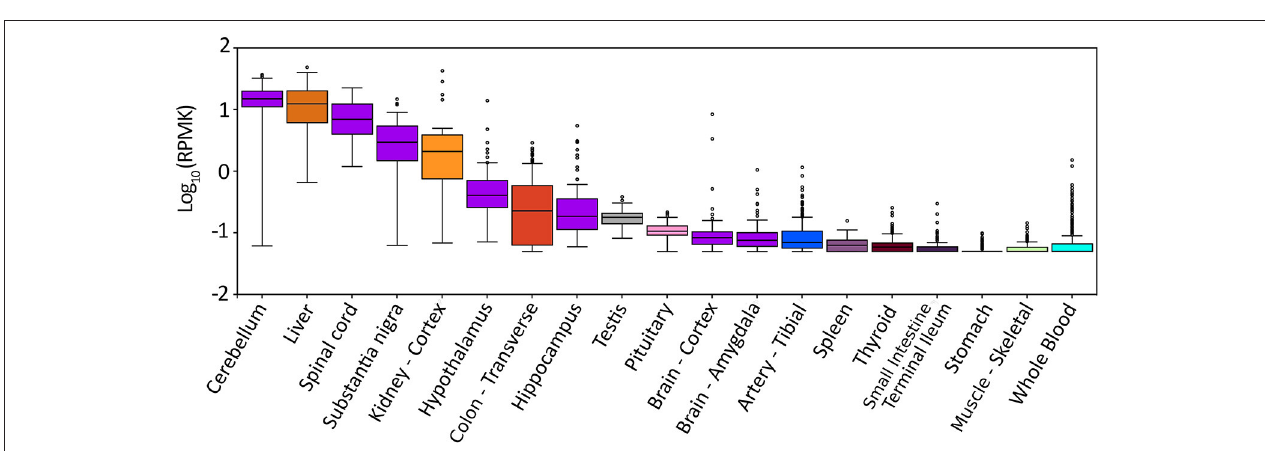
FIGURE 2 | Expression pattern of DAO gene in different tissues. Box plot of expression levels of DAO gene in different human tissues. Values are shown in RPKM (reads per kilobase of transcript per million mapped reads), calculated from a gene model with isoforms collapsed to a single gene. No other normalization steps have been applied. Box plots are shown as median and 25th and 75th percentiles; points are displayed as outliers if they are above or below 1.5 times the interquartile range. The data presented in this plot were obtained from the Genotype-Tissue Expression (GTEx) Project Portal, dbGaP accession number phs000424.v6.p1 on 09/04/2017